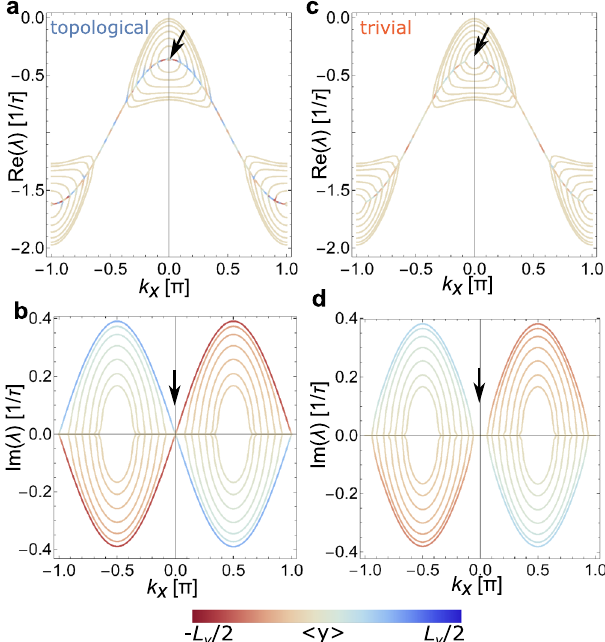
Fig. 3 Stochastic chiral edge states. Real ( a , c ) and ( b , d ) imaginary parts of the normal modes of the rate matrix ^ W for open-boundary conditions in the y -direction, for the ( a , b ) topological and ( c , d ) trivial devices. The color denotes the average 〈 y 〉 position of a normal mode. Modes in green are delocalized and correspond to bulk states. Modes in blue and red correspond are strongly localized on the top or bottom edges, respectively. The arrows in ( c , d ) highlight the presence or absence of topological edge modes close to k = 0, where their lifetime Re ð λ Þ is